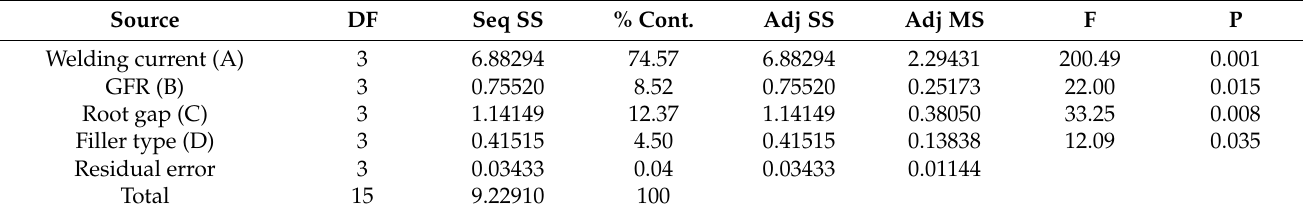
Table 14. Analysis of variance (ANOVA) for